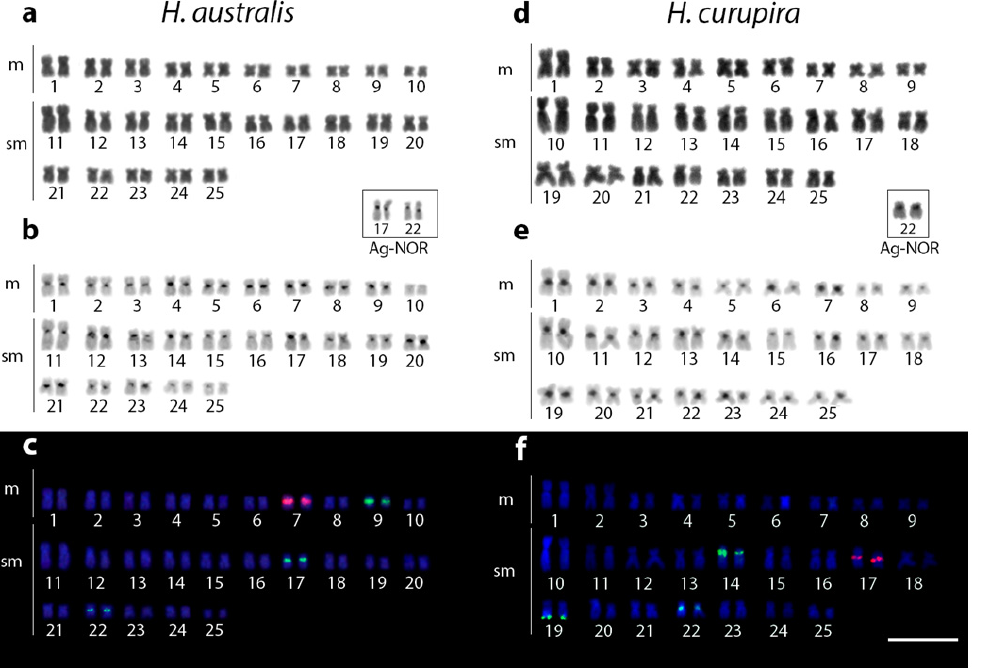
Figure 2. Karyotypes of Hoplias australis ( a – c ) and H. curupira ( d – f ) organized from Giemsa-stained ( a , d ) and C-banded ( b ),( e ) chromosomes. Dual-color fluorescence in situ hybridization (FISH) karyotypes with 5S (red) and 18S (green) rDNA probes are also shown for both species ( c ) and ( f ), respectively, with chromosomes counterstained with DAPI (blue). Scale bar = 5 μ m.